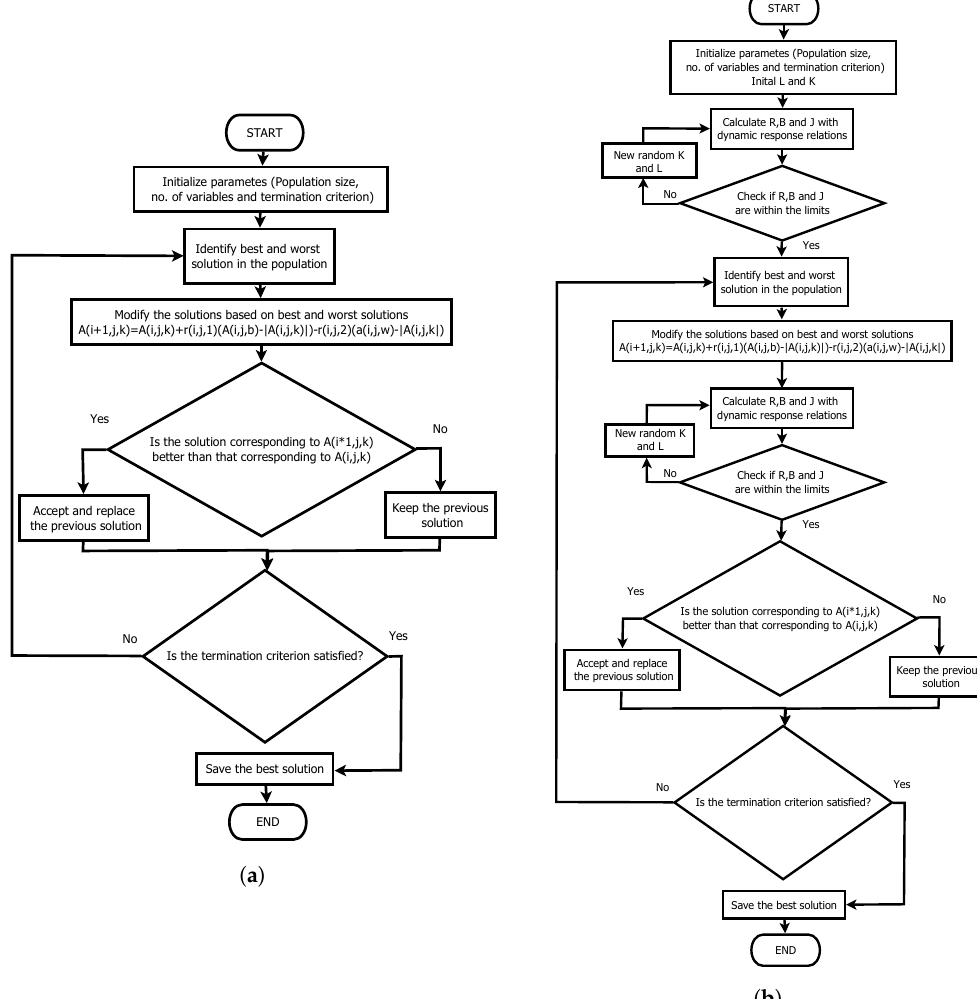
Figure 4. Jaya algorithm. ( a ) Original Algorithm; ( b ) Modified algorithm with dynamics